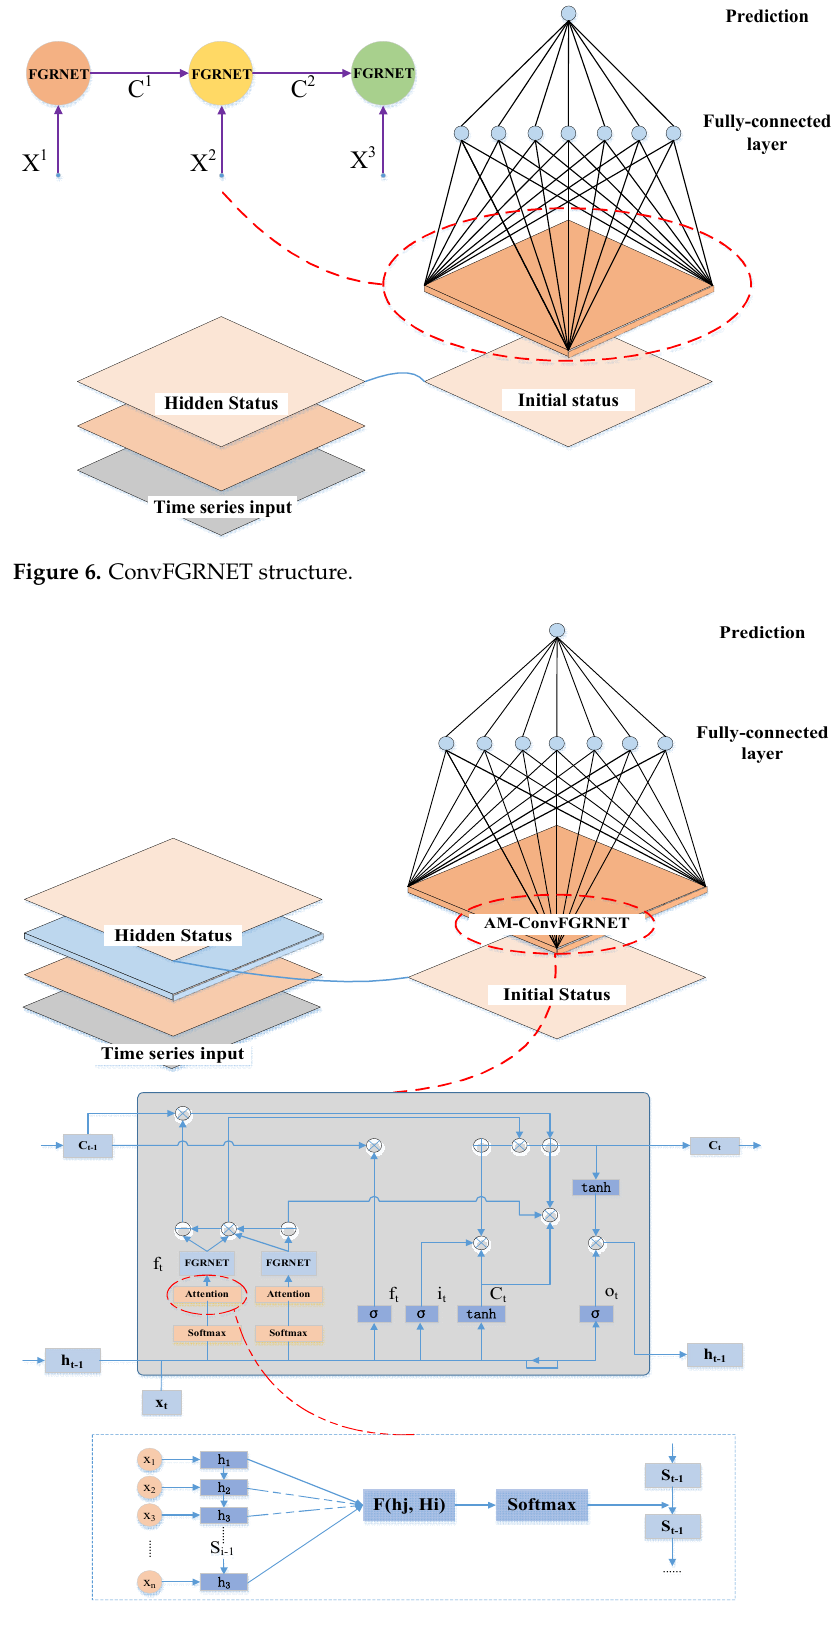
Figure 7. Structure of AM-FGRNET.